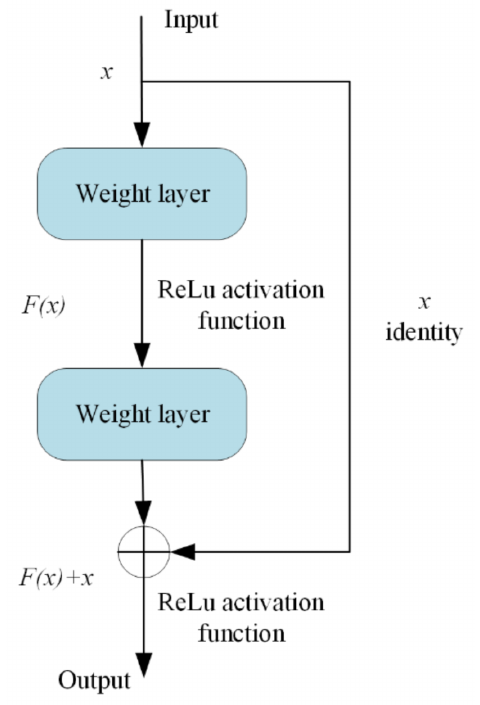
Figure 3. Residual block structure of